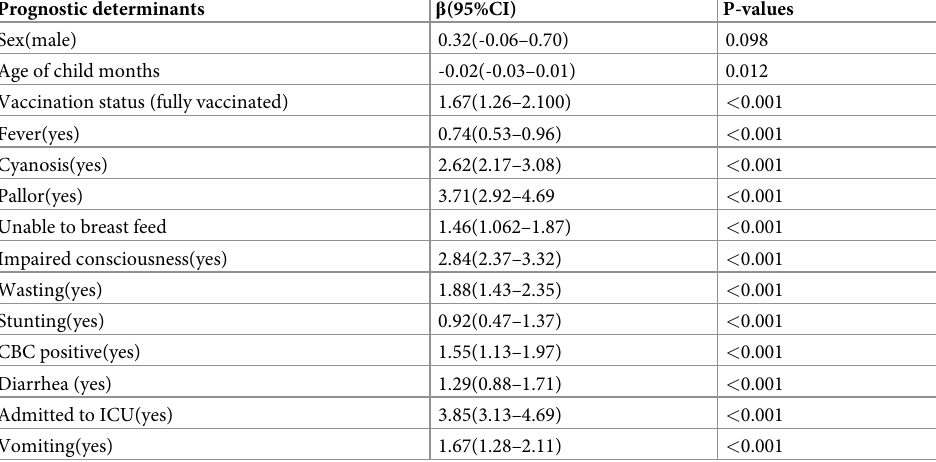
Table 2. Bivariate regression analysis to develop and validate a prediction model for poor outcomes of Pneumo- nia in